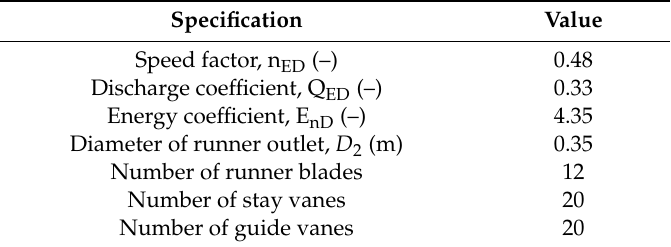
( b ) Location of anti-cavity fins Figure 1. ( a ) 3-D model of the DT with ( b ) location of anti-cavity fins in the Francis turbine model. Table 1. Francis turbine model specifications. Table 1. Francis turbine model